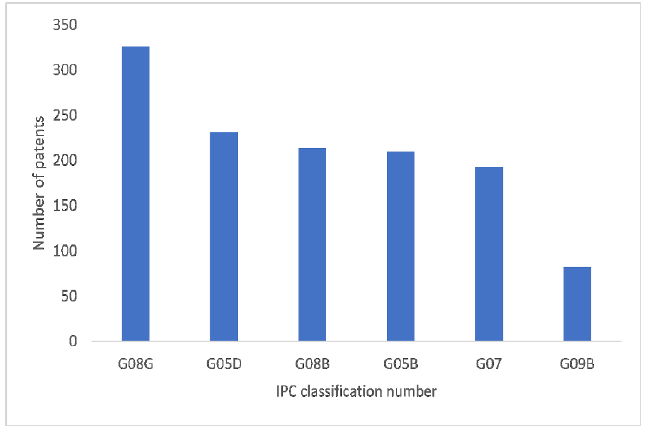
Fig. 6 IPC distribution in control.